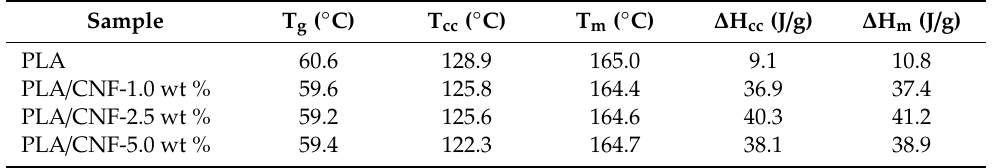
Table 2. DSC thermal characteristics of PLA and PLA / CNF